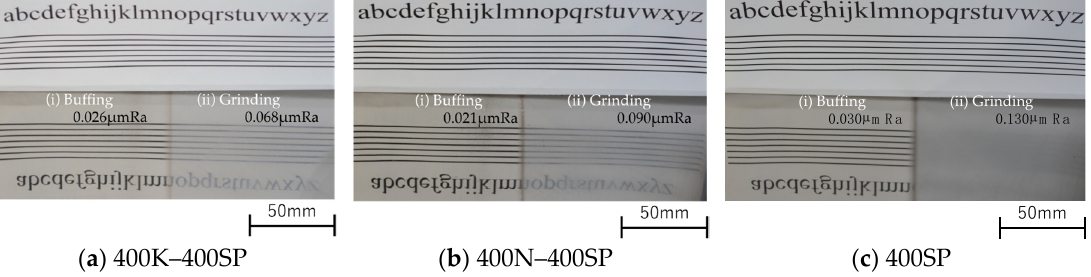
Figure 16. Surface condition and roughness when grinding with the 400K–400SP, 400N–400SP, and 400SP combinations.